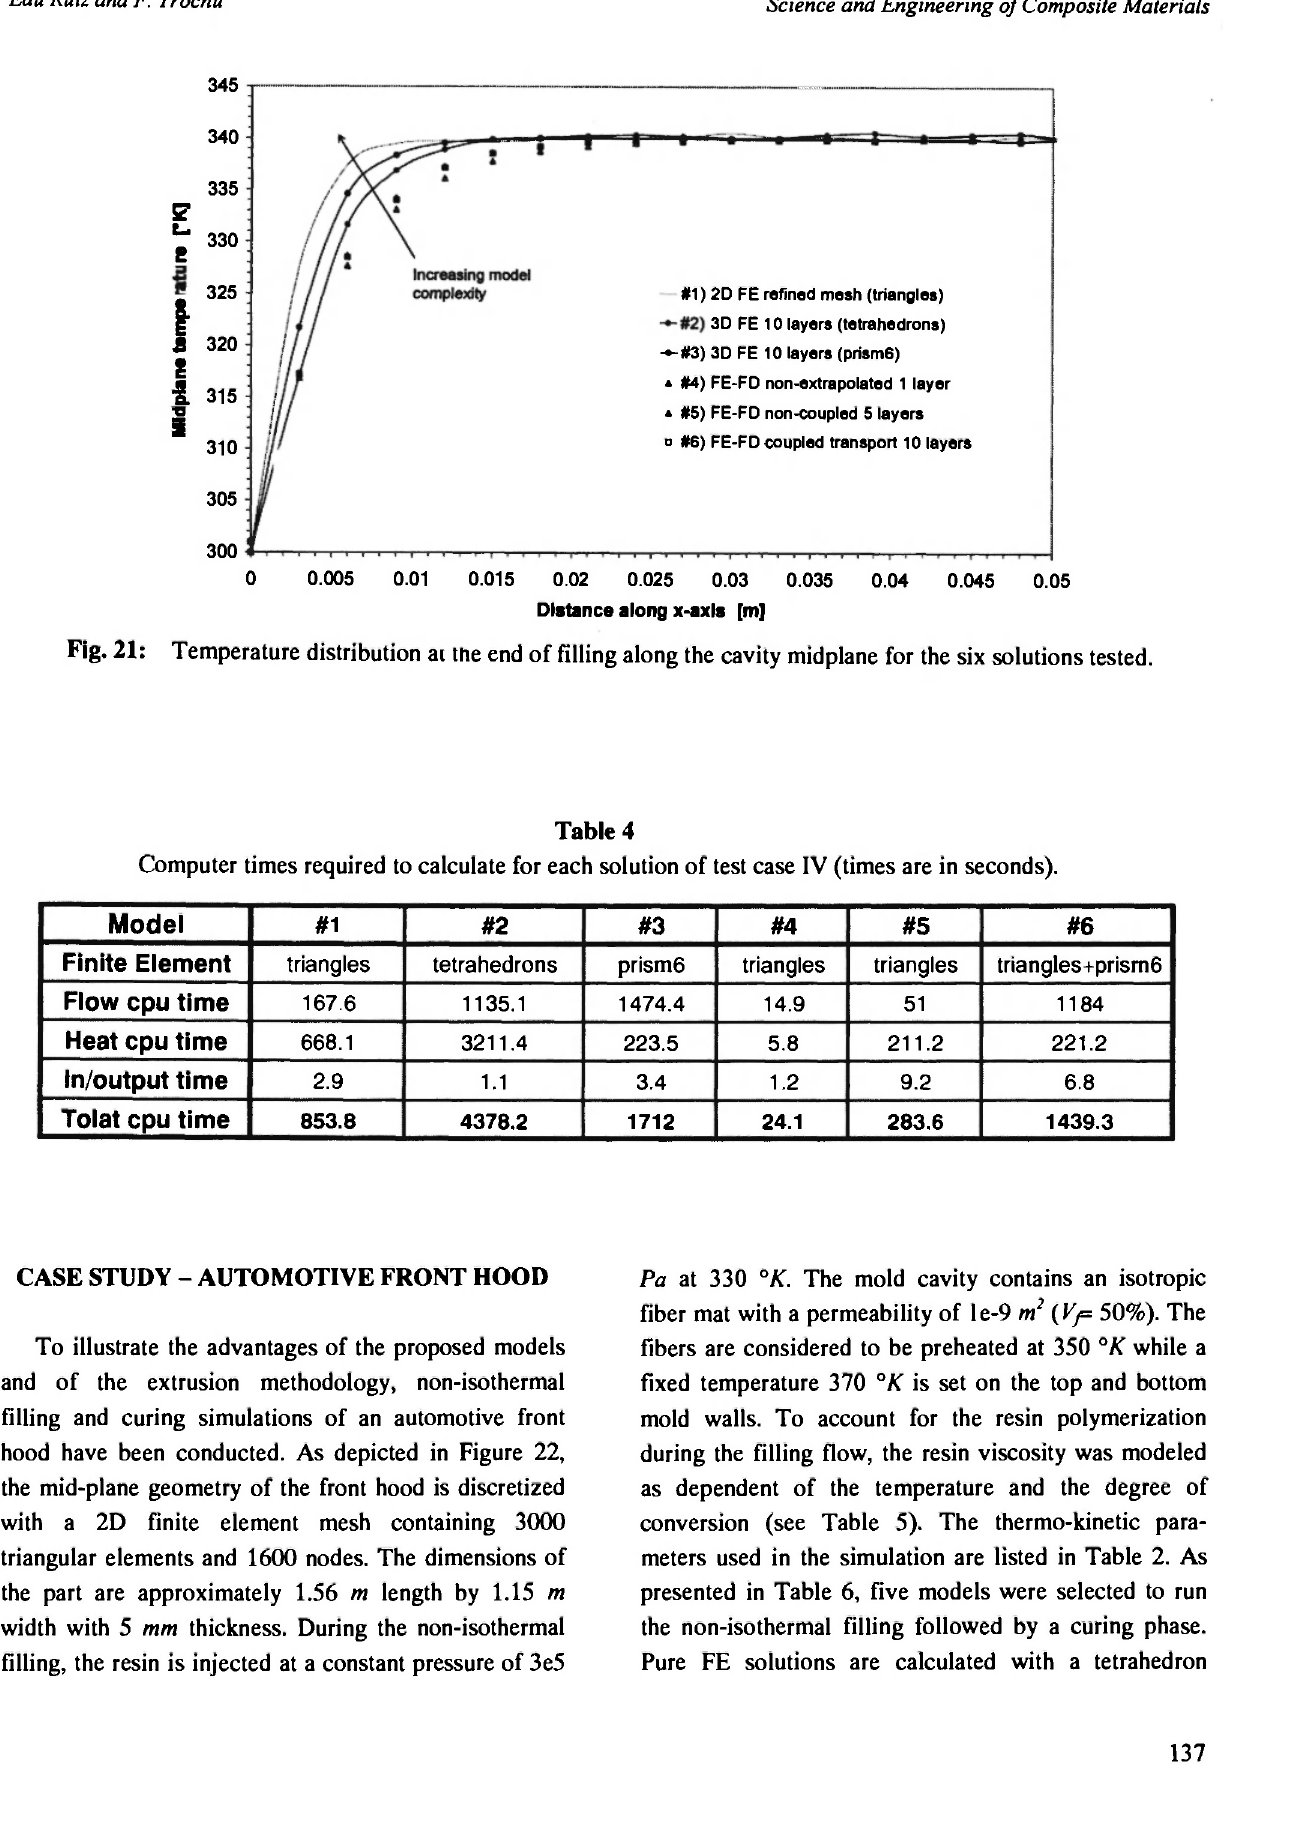
#1) 2D FE refined mesh (triangles) 3D FE 10 layers (tetrahedrons)